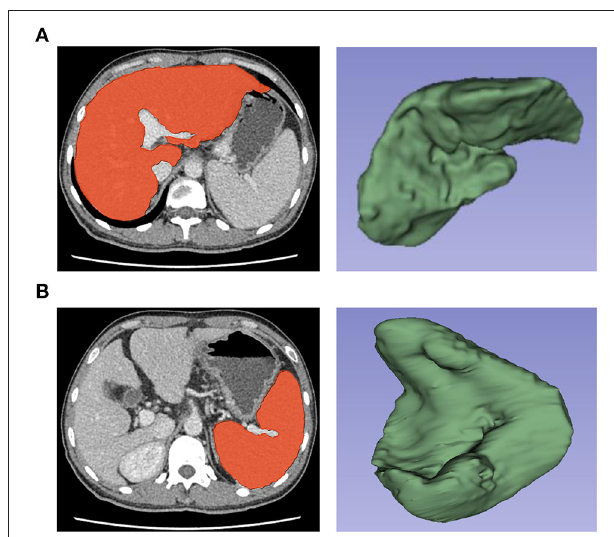
FIGURE 1 | Selection and three-dimensional reconstruction of Regions of interest (ROIs) in the liver and spleen. Delineation of the liver (A) and spleen (B) as ROIs and three-dimensional reconstruction of ROIs by using 3D-slicer software for the extraction of radiomics